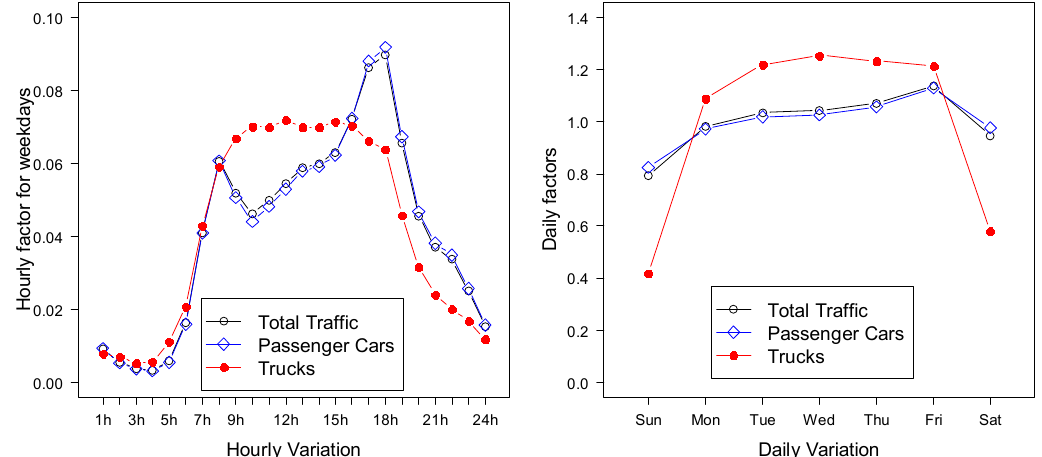
Figure 3. Typical hourly and daily variations of traffic at Leduc Highway 2A.